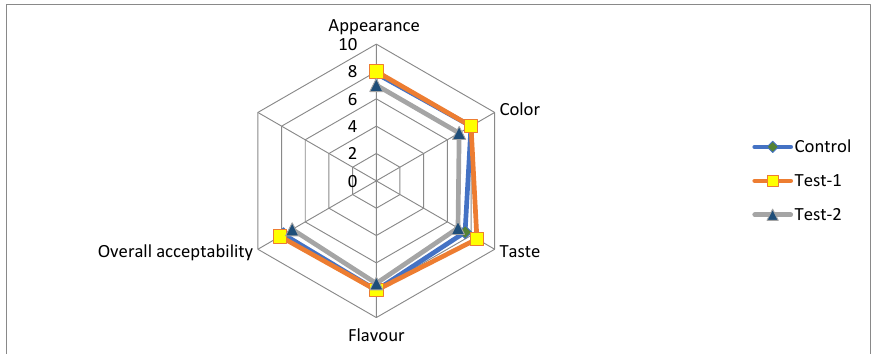
Figure 4. Sensory analysis for all of the film specimens: control (pectin + glycerol); test-1 (flaxseed +pectin + glycerol); test- 2 (flaxseed + glycerol).